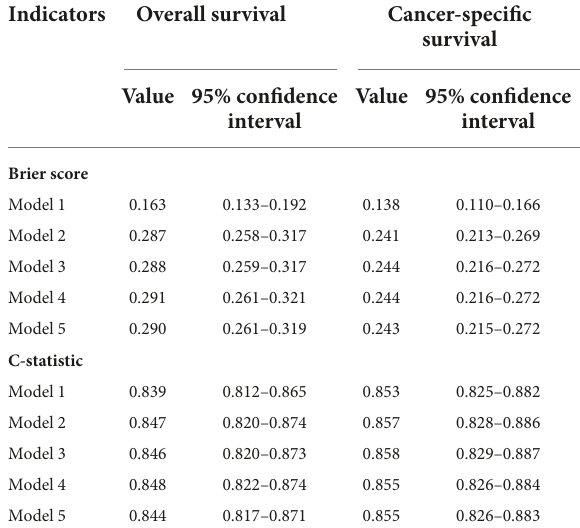
TABLE 2 Brier scores and C-statistics of candidate multivariate Cox proportional hazard models in predicting patient overall survival and cancer-specific survival outcome within the imputed training